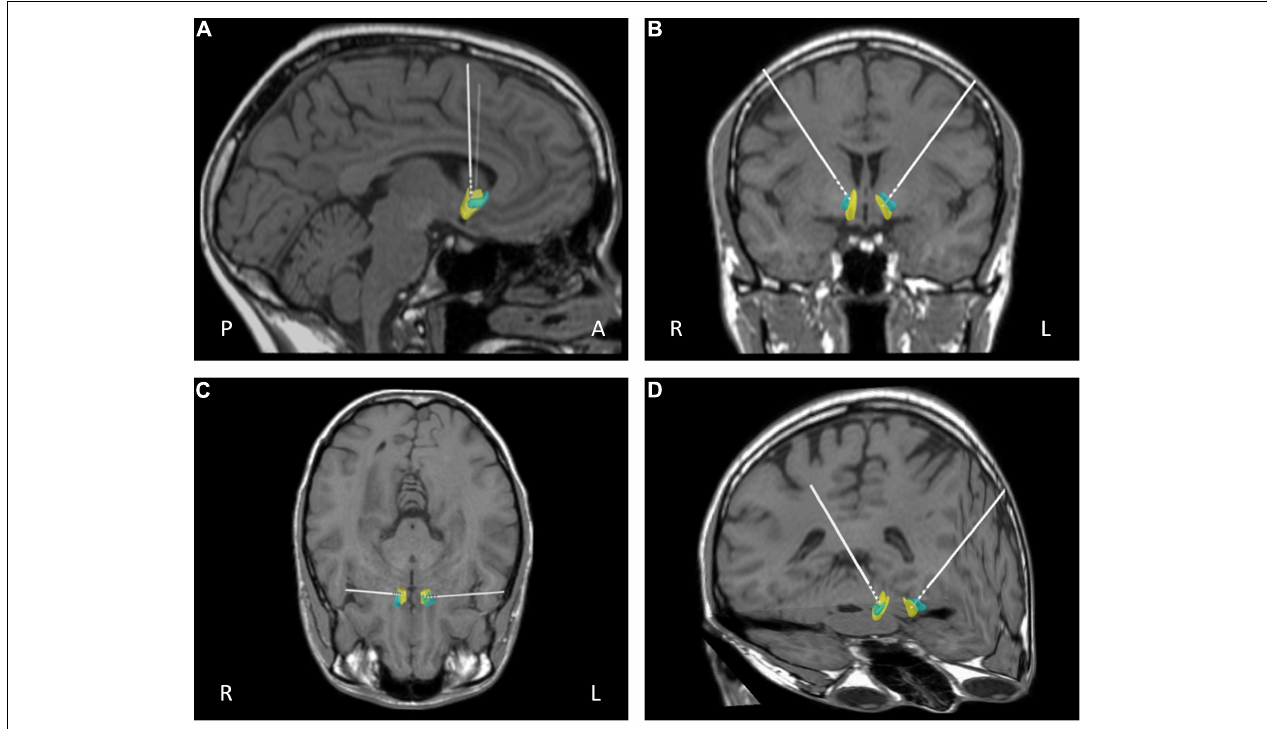
FIGURE 1 | Representative post-operative reconstruction of DBS electrode in native patient space with nucleus accumbens (NAcc) mask (Cartmell et al., 2019): A, anterior; P, posterior; R, right; L, left; blue, core; yellow, shell. (A) Sagittal view. (B) Coronal view. (C) Axial view (D) 3D reconstruction.